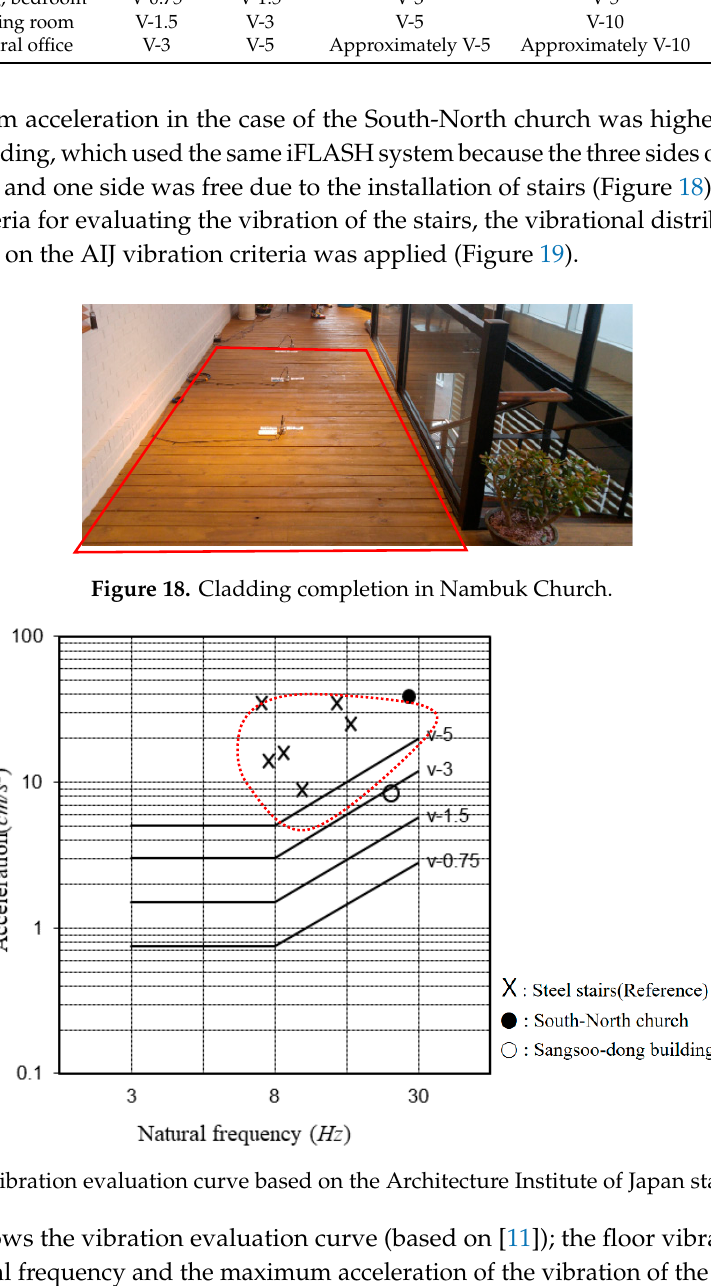
Figure 20. Vibration evaluation curve based on the ISO 2631-2 floor vibration standard [29].